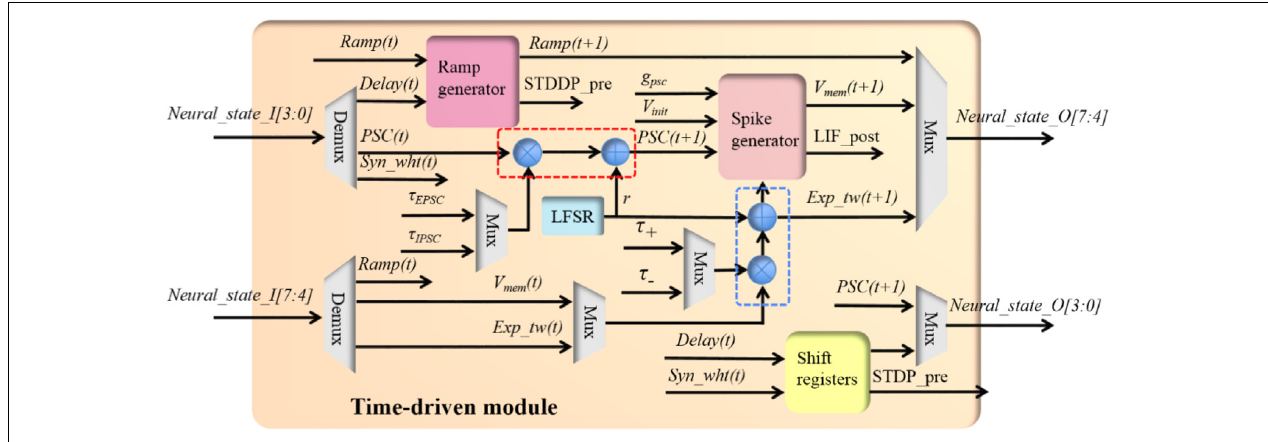
FIGURE 5 | The structure of the time-driven